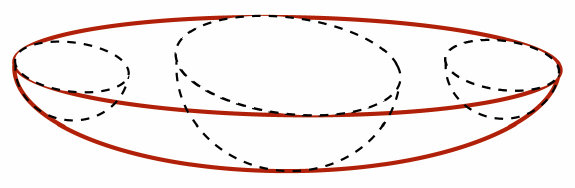
Figure 7. 3D representation of the incision retraction.